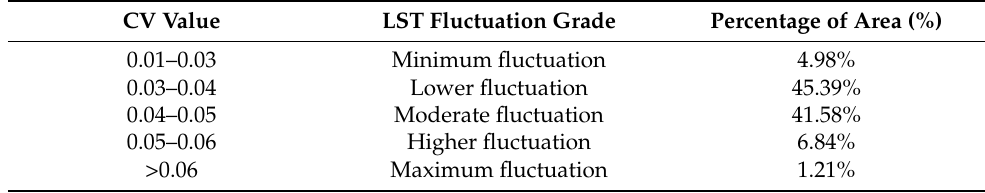
Table 3. Classification of LST coefficient of variation.